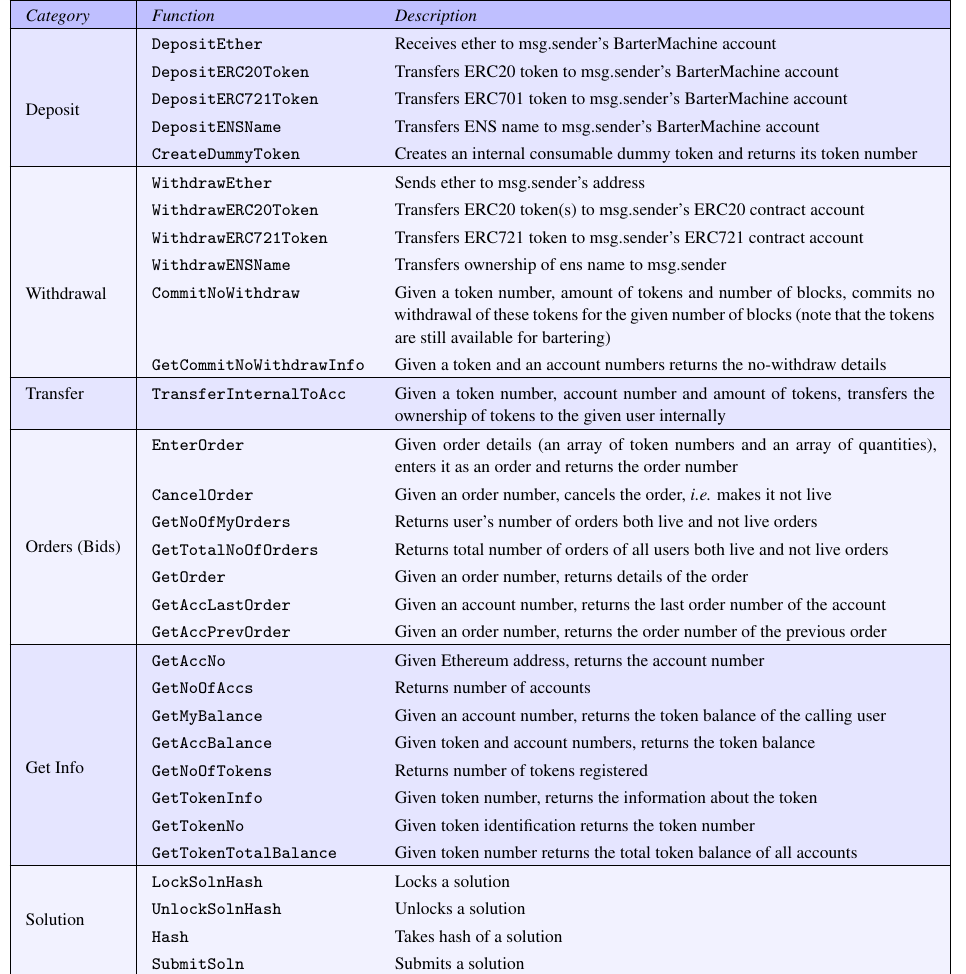
Table 1. BarterMachine Contract Functions (partial